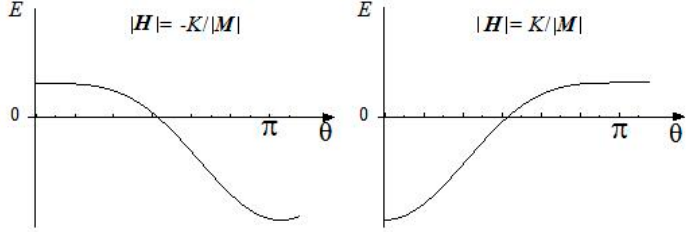
Figure 3. Calculated magnetic energy E as a function of angle θ for the special case where | H | = ± K /| M |.